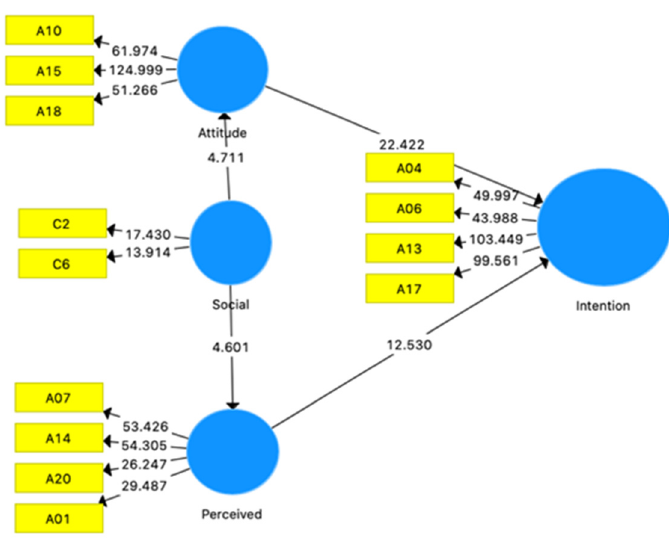
Figure 6. Bootstrap analysis to model 2 (men).